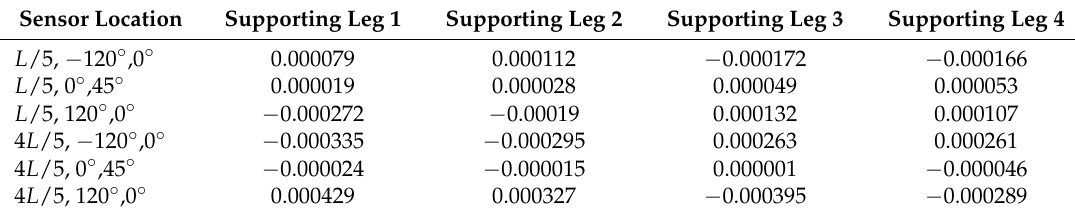
Table 2. The typical strain measurements at a pitch angle of 30°.